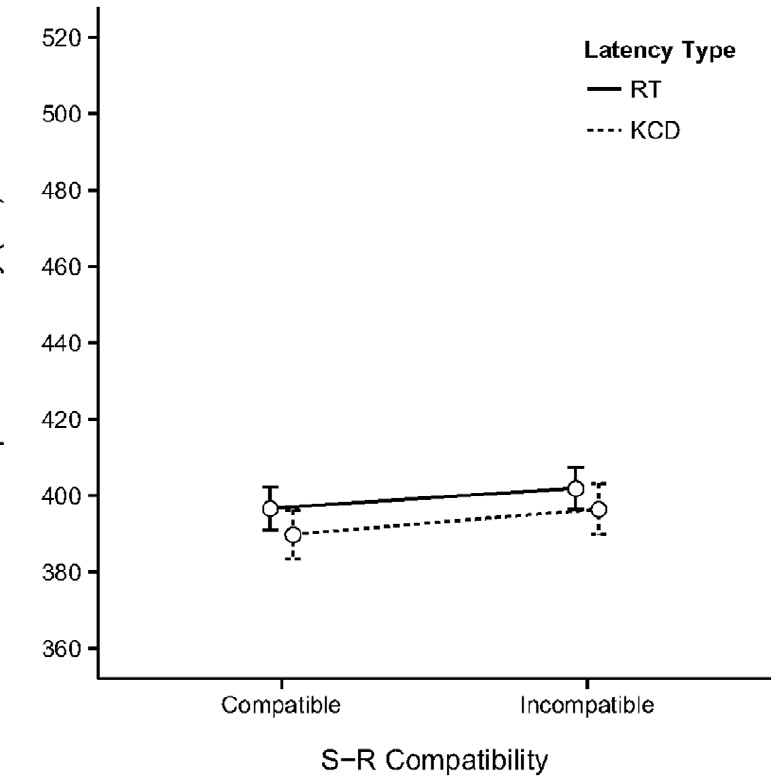
Figure 3. Results of the test phase of the two single-movement response variations of Experiment 2. The observed means (with 95% CI) for the two types of response latency measured in Experiments 2A and 2B as a function of S-R Compatibility of the trials. The values of the means, confidence intervals and size of the Compatibility Effect (CE) are reported in Table S1. In Experiment 2A participants had to press and hold down the correct key upon stimulus presentation, in Experiment 2B participants had to release the correct key upon stimulus